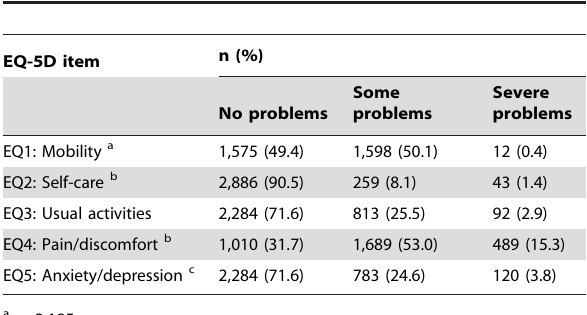
Table 3. Distribution of responses in the EQ-5D dimensions in the study sample.